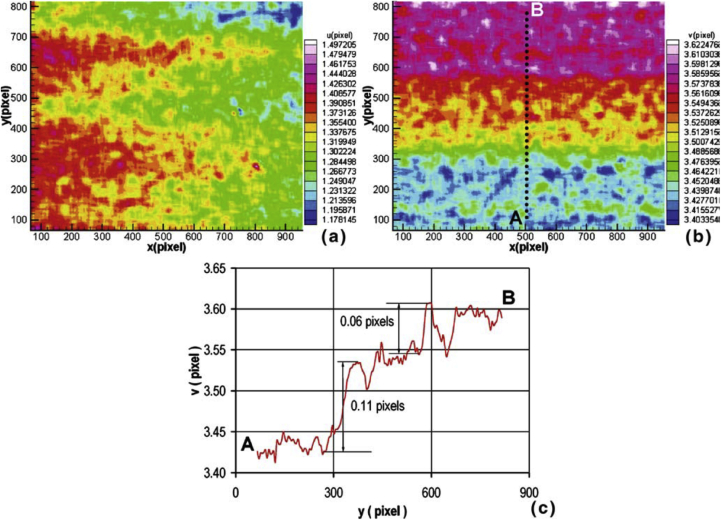
Displacement fields at 5000x for gold coated on aluminium using a FEI Quanta-200 SEM: (a) horizontal; (b) vertical. The scale bar shows the change in displacement in pixels. From Sutton et al. [2007].8